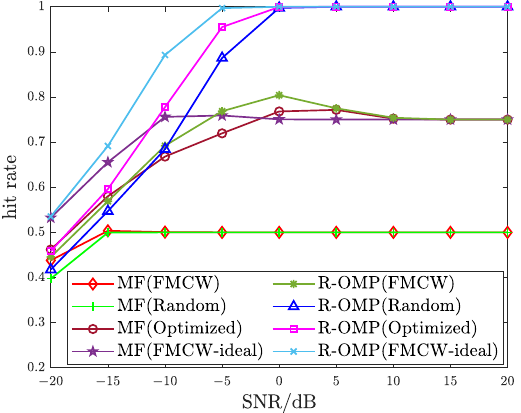
Figure 12. Range recovery hit rate versus different SNR.